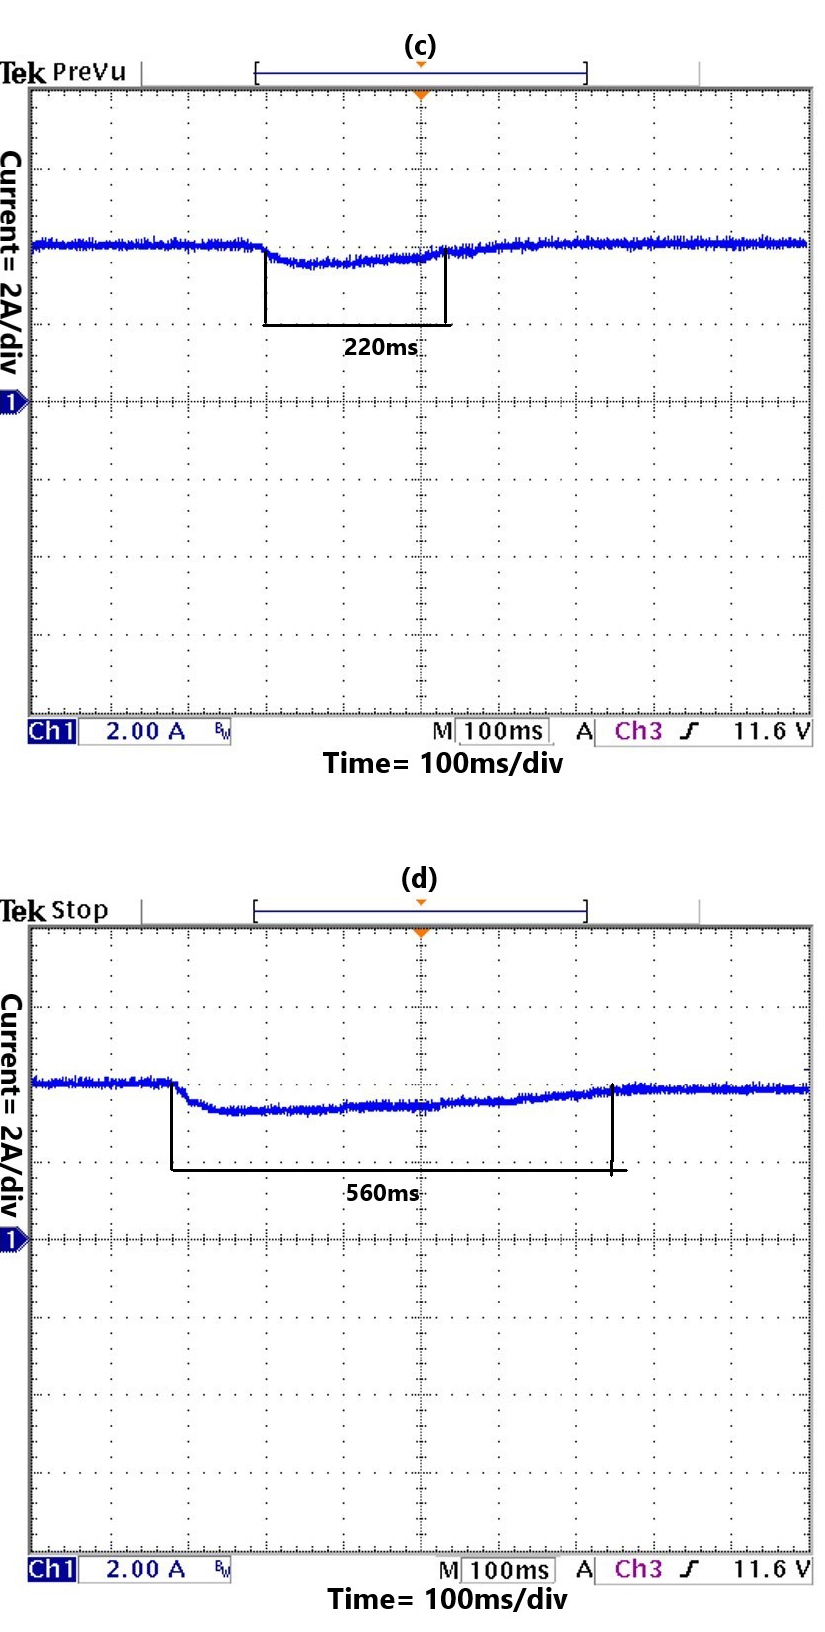
Figure 19. Experimental results when there is a 25% change in load resistance: ( a ) FCC; ( b ) LCFF; ( c ) MBPS; ( d ) PI.